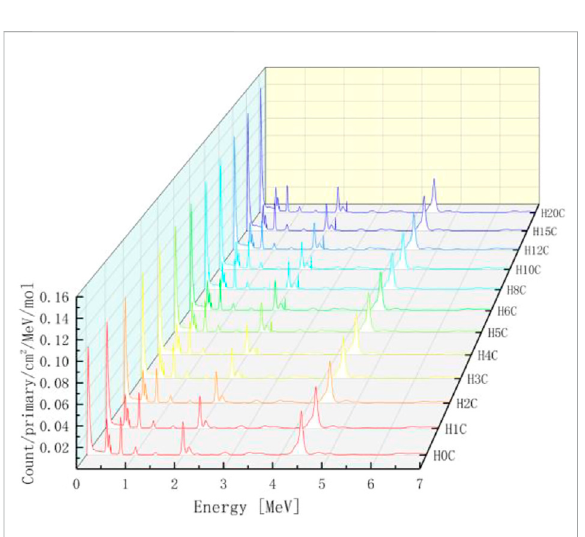
FIGURE 11 Molar PGS from combinations of carbon and hydrogen. The characteristic gamma lines from carbon come to the same level in molar PGS except at an energy of approximately 2.23